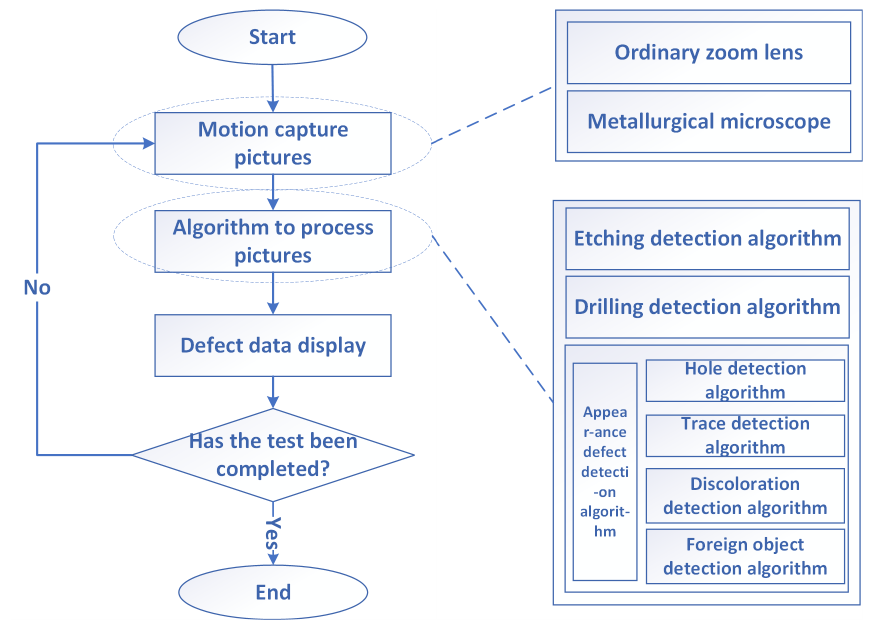
Figure 9. Schematic diagram of the main interface of the